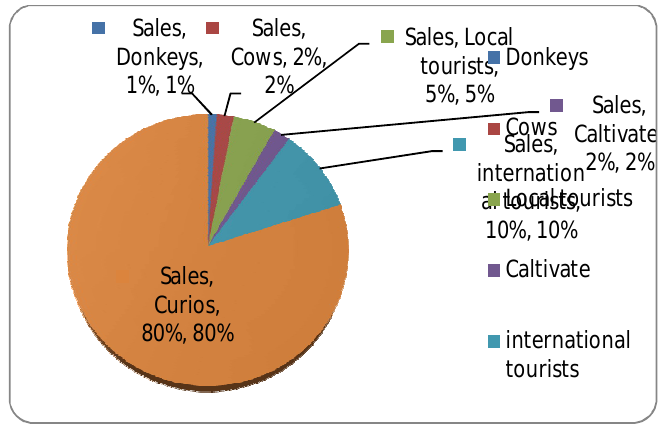
Figure 8: Social- activity per household in Mukuni